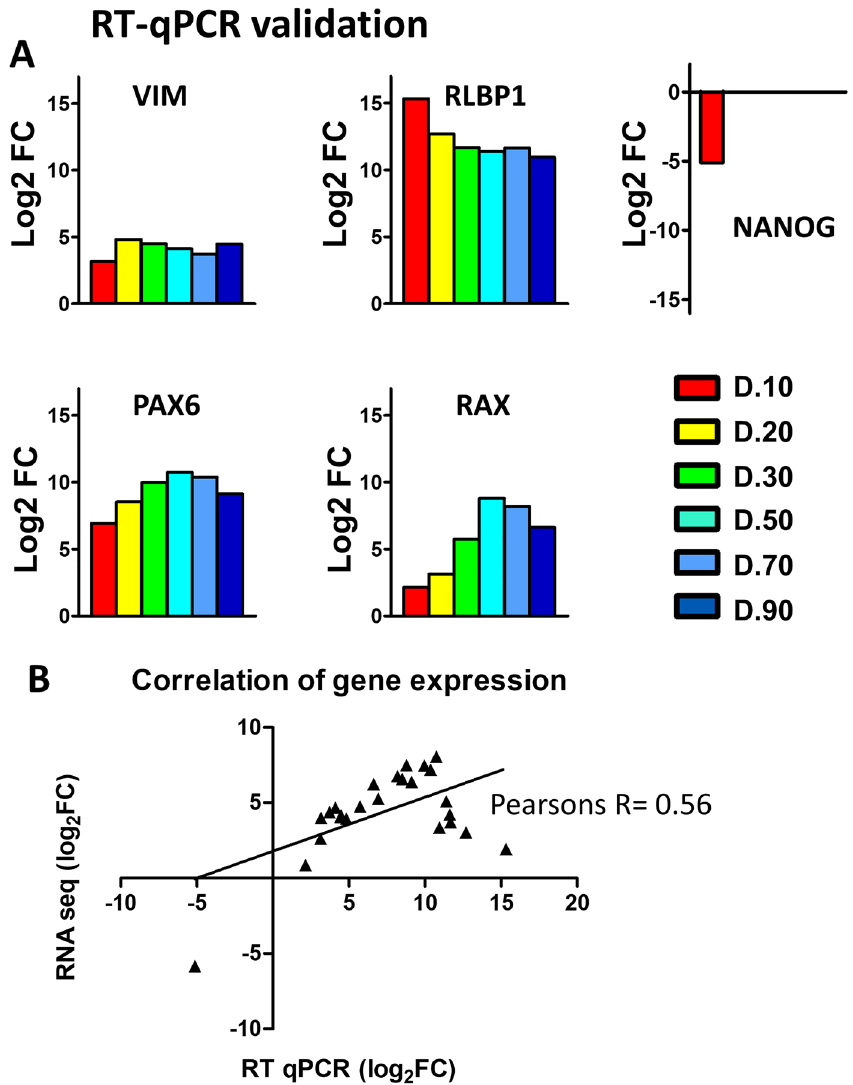
Figure 7. Validation of RNA seq analysis. ( A ) Bar graphs show log 2 fold change of selected genes associated with Müller glia throughout the different stages of organoid formation and maturation. ( B ) The plot shows gene expression as log 2 fold change as determined by qPCR and RNA-seq. The linear regression analysis and Pearson’s correlation co-efficient (Pearsons R = 0.56; R 2 = 0.31; **P = 0.038) are